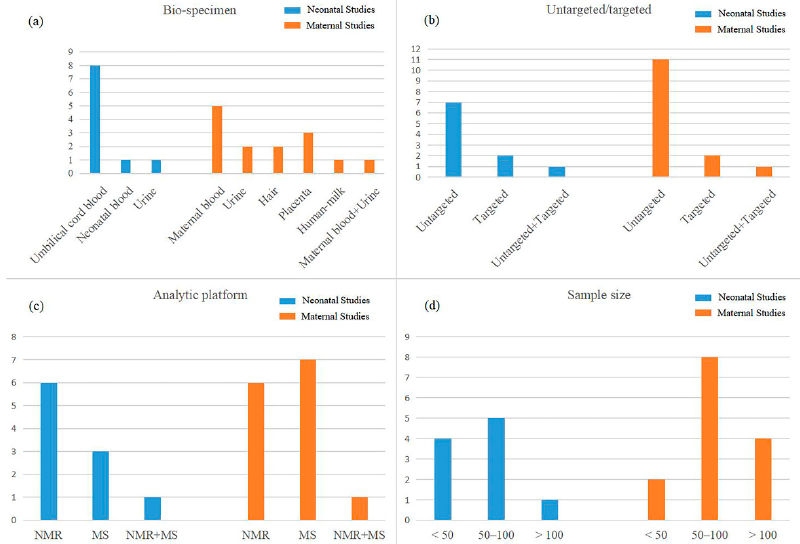
Figure 2. Numbers of the human neonatal and maternal studies according to ( a ) bio-specimen, ( b ) untargeted/targeted, ( c ) analytical platform, and ( d ) sample size.